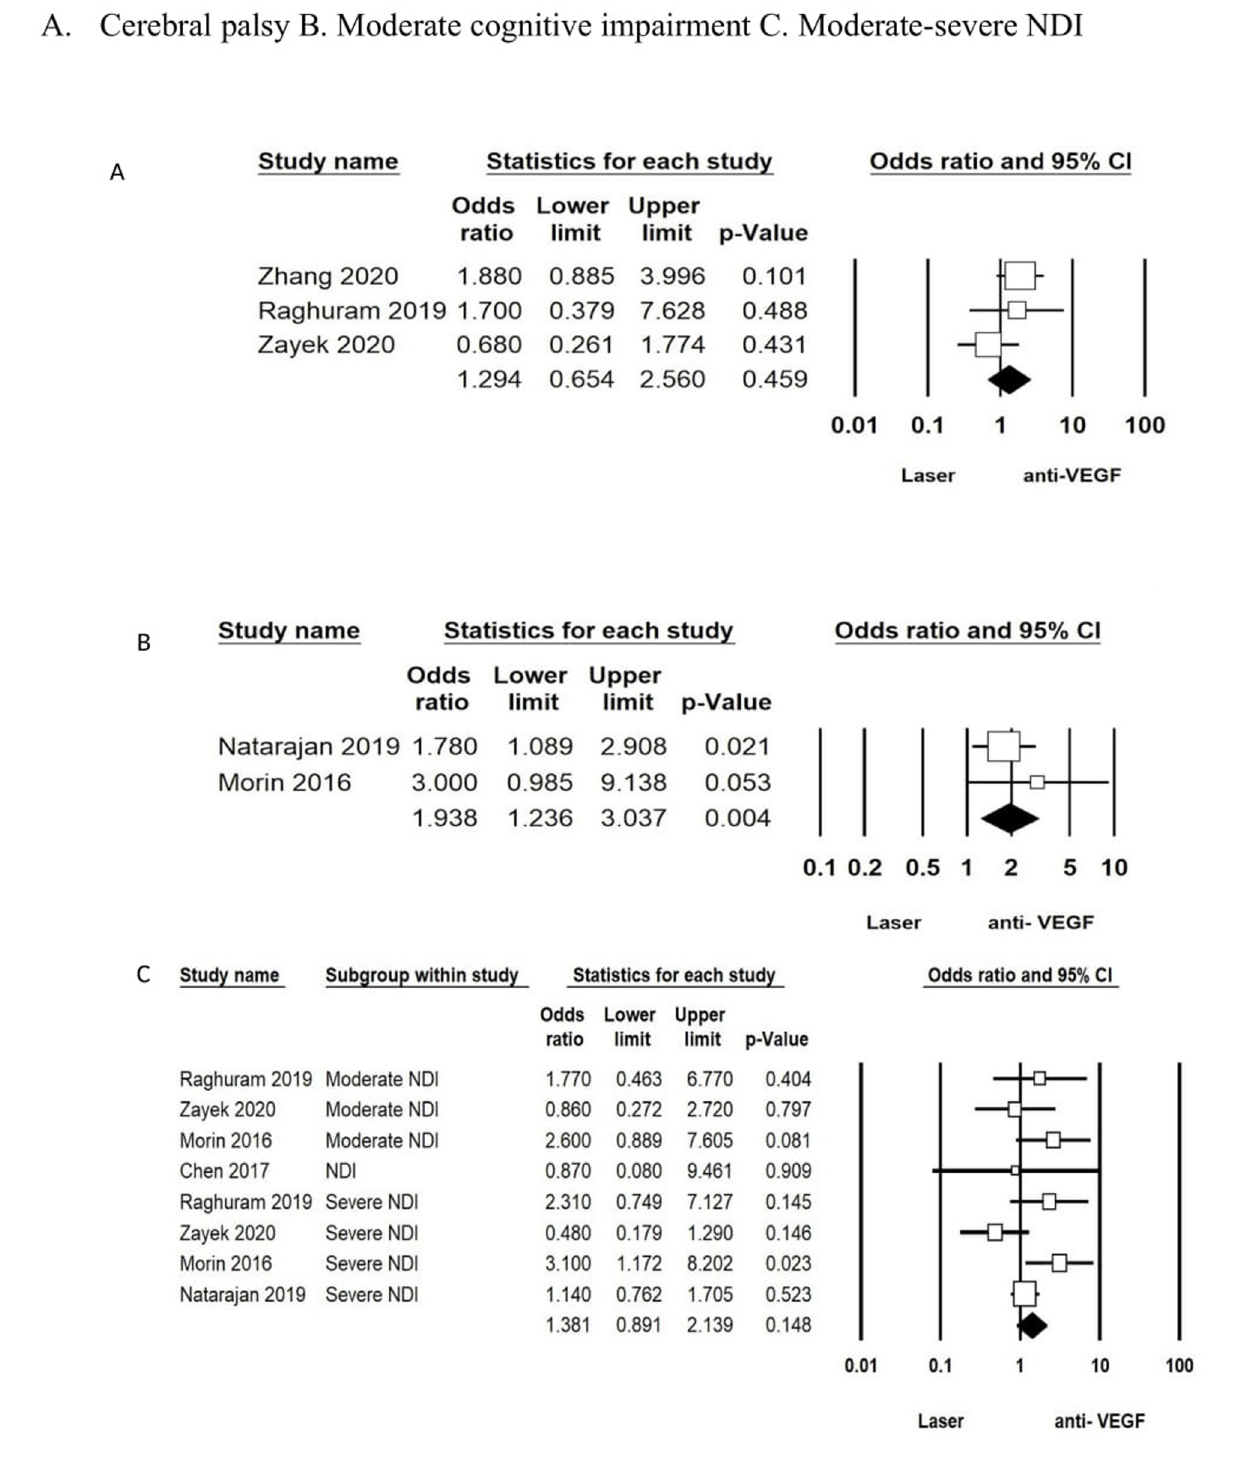
FIGURE 3 Forest plots: for adjusted OR analysis — laser vs. “ anti-VEGF ”